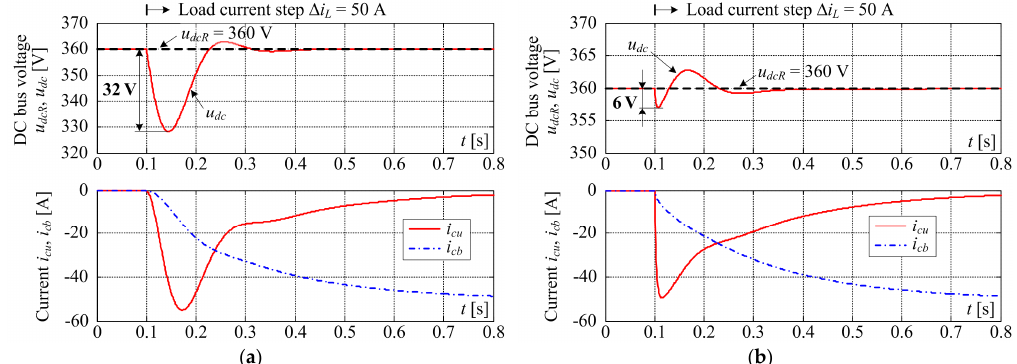
Figure 9. DC bus control voltage and battery/ultracapacitor ESS current simulation results for abrupt load current change when PI controller is used alone ( a ), and with direct feed-forward load compensator ( b ).